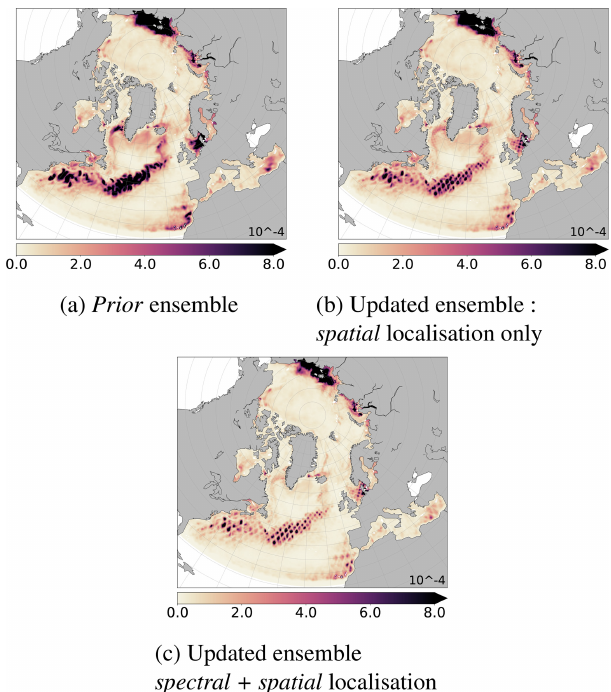
Figure 12. Same as Fig. 11 but after extraction of the large scales ( l ∈ [0 ; l c ], with l c = 34; see Eqs. 2 and